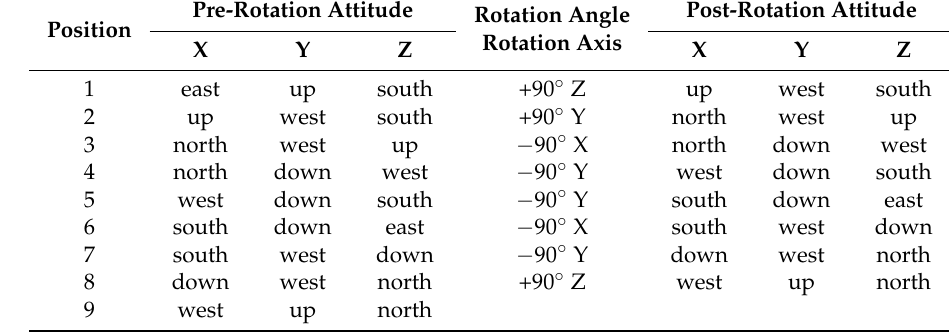
Figure 4. Rotation sequence. Table 1. Position arrangement.